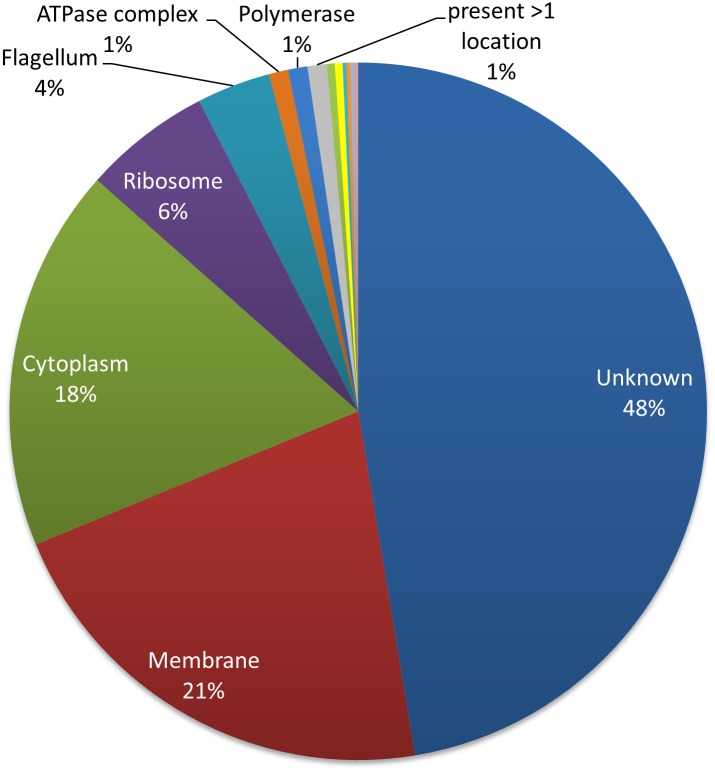
Pie diagram depicting the subcellular localization of T. pallidum detected by MS analysis (N = 557).Almost half of the detected proteins (N = 265; 48%) did not have an annotated cellular location. Of the known locations, membrane (N = 116; 21%), cytoplasm (n = 99; 18%), ribosomal (N = 33; 6%) and flagella (N = 19; 3%) were the most represented cellular localizations.